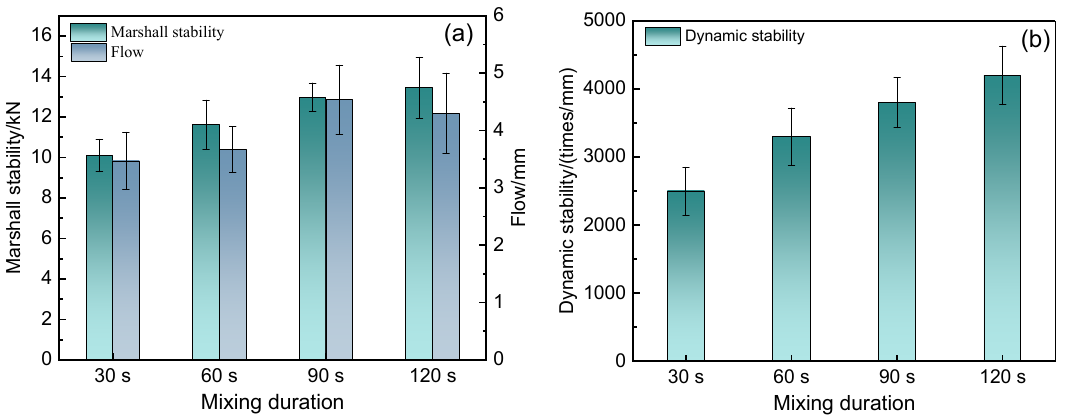
Figure 16. High-temperature resistance test: ( a ) Marshall stability and flow results; ( b ) rutting test results.